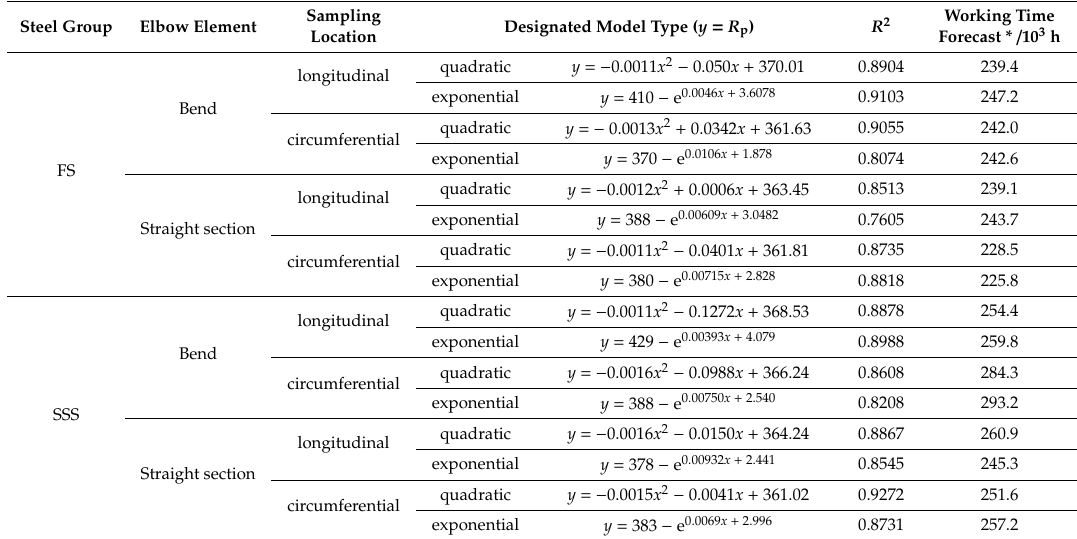
Table 4. Summary set of prognostic models of R p for FS and SSS steel groups designated.